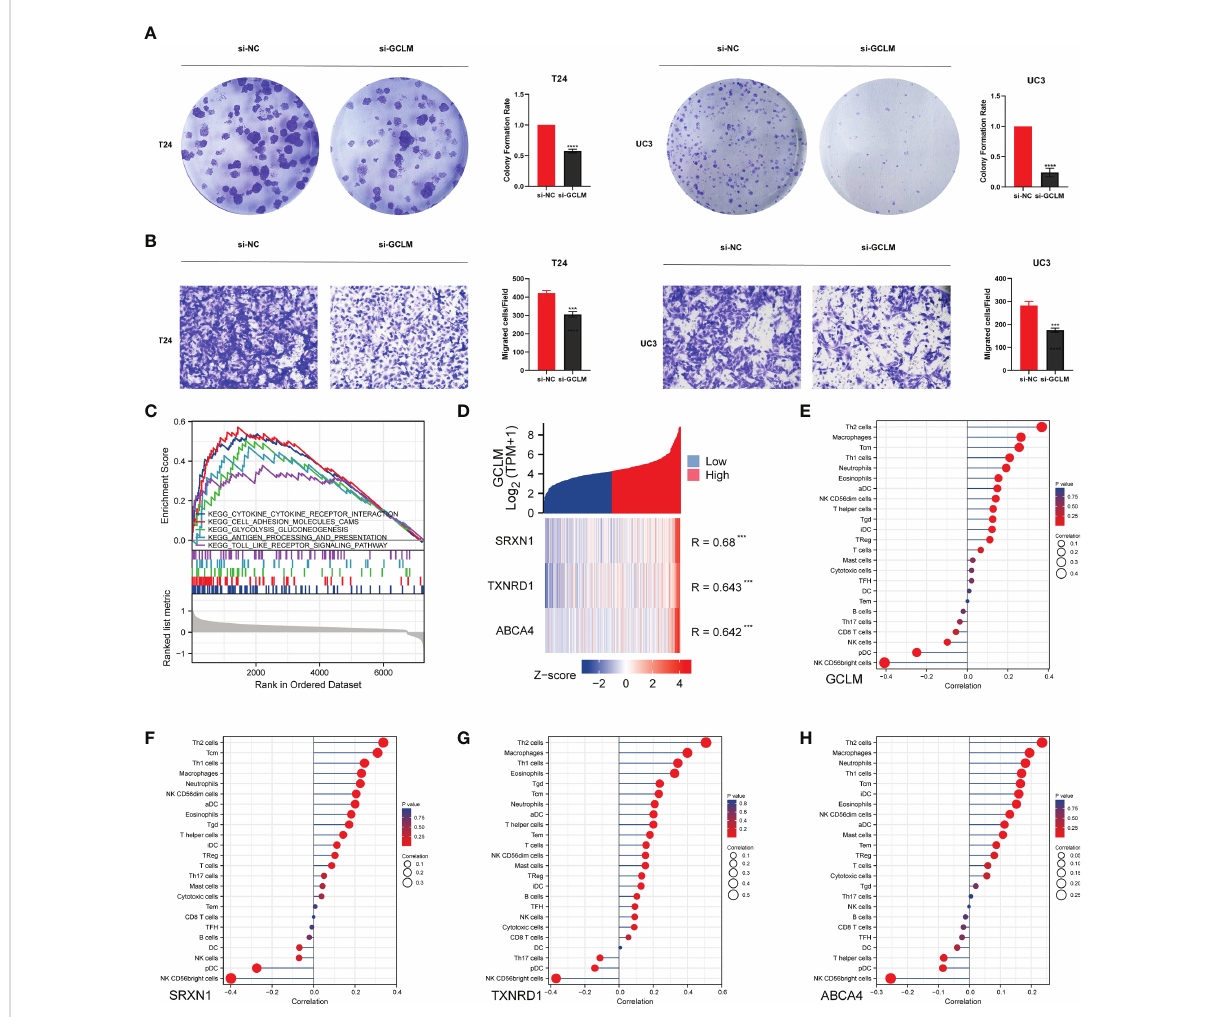
FIGURE 7 GCLM promotes tumor progression and is associated with immune in fi ltration in BCa. (A, B) Knockdown the expression of GCLM can signi fi cantly inhibit the (A) colony formation ability and (B) migration ability of T24 and UC3 cells. (C) The results of GSEA algorithm analysis indicated the potential KEGG signaling pathways of highly expressed GCLM in BCa. (D) The heatmap indicated that the SRXN1, TXNRD1 and ABCA4 are top 3 GCLM co-expressed genes in TCGA-BLCA cohort. The ssGSEA analysis of the correlations of (E) GCLM, (F) SRXN1, (G) TXNRD1 and (H) ABCA4 with immune cells in BCa. ***p < 0.001, ****p <